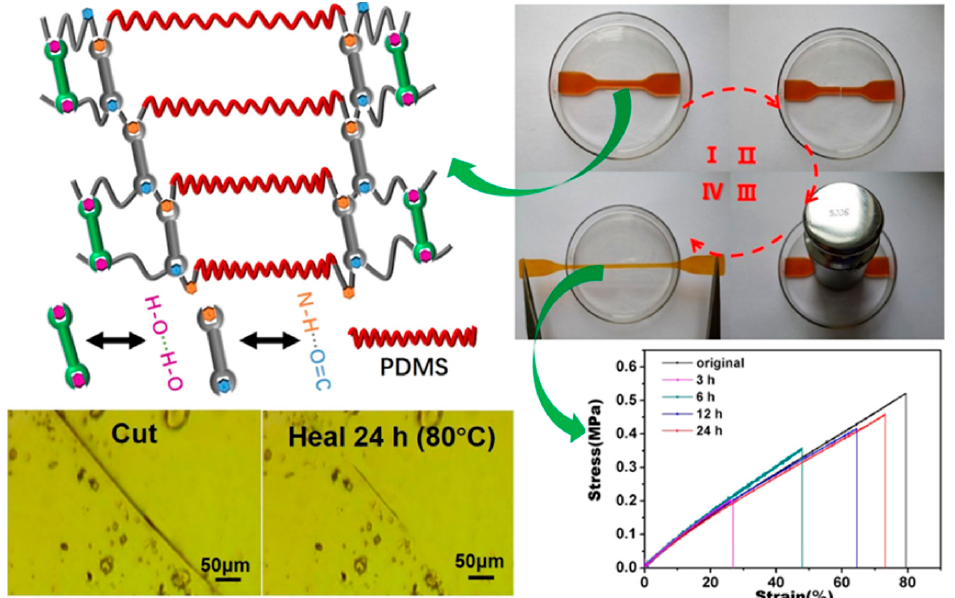
Figure 12. Hydrogen bonding network with silicone rubber (PDMS) represents the self-healing properties [96]. Reprinted with permission from [96]. Copyright 2019 American Chemical Society.